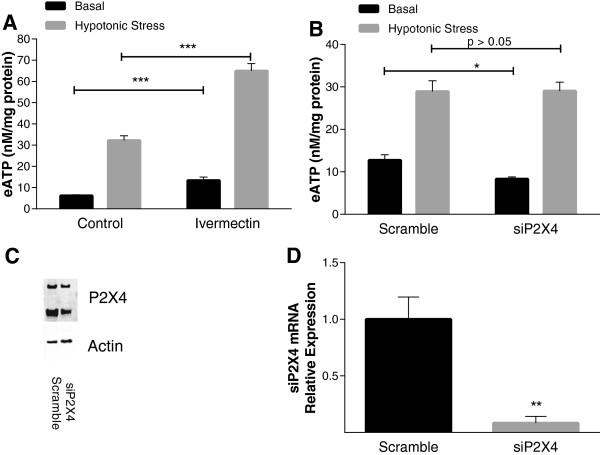
Role of P2X4 receptors in signaling and eATP release by chondrocytes. (A) Chondrocytes were treated with no additives (control) or 10 μM ivermectin in 100 μl of media for 30 minutes: 35 μl of media were removed and replaced with 35 μl of media (black bars) or 35 μl of H2O (gray bars). eATP levels were measured after 10 minutes. Bars represent mean ± standard error. Under control conditions, a hypotonic challenge consistently increases (eATP). Ivermectin increased eATP levels after a hypotonic challenge (n = 8: ***P <0.001). (B) Chondrocytes were transfected with siRNA for P2X4 or a scrambled control. After 48 h, cells were exposed to hypotonic media for 10 minutes (gray bars) or isotonic media (black bars) and eATP levels were measured. Bars represent mean ± standard error. eATP levels in P2X4 -silenced chondrocyte media were similar to those in the scramble control media (n = 8; P >0.05). In parallel cultures at 48 h, protein and mRNA were isolated from scramble or siRNA-treated cells as described and used to assess levels of P2X4 receptor protein (C) and mRNA (D). siRNA for P2X4 decreased P2X4 mRNA (**P <0.01). Western blots compare effects on P2X4 receptor versus actin.